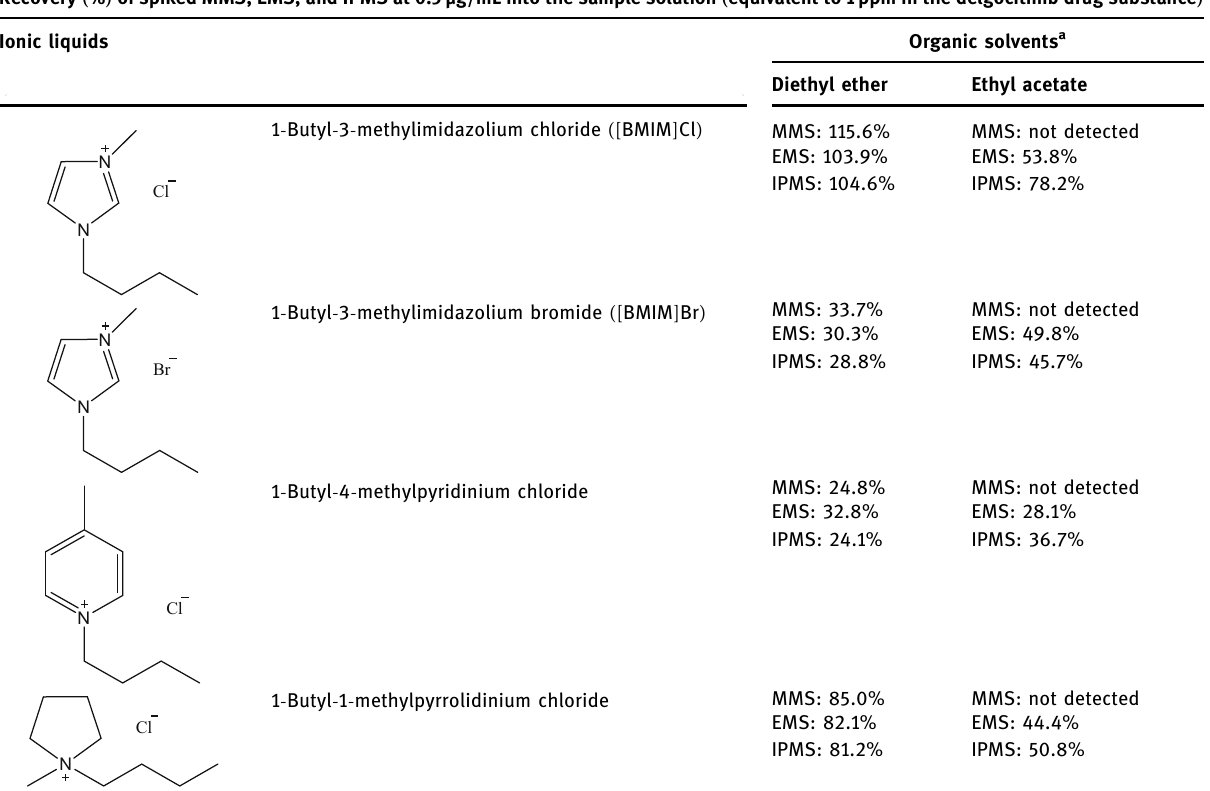
Table 2: Summary for the screening ionic liquids and organic solvents focused on the cation ’ s structure and the anion ’ s electronegativity Recovery ( % ) of spiked MMS, EMS, and IPMS at 0.5µg/mL into the sample solution ( equivalent to 1 ppm in the delgocitinib drug substance